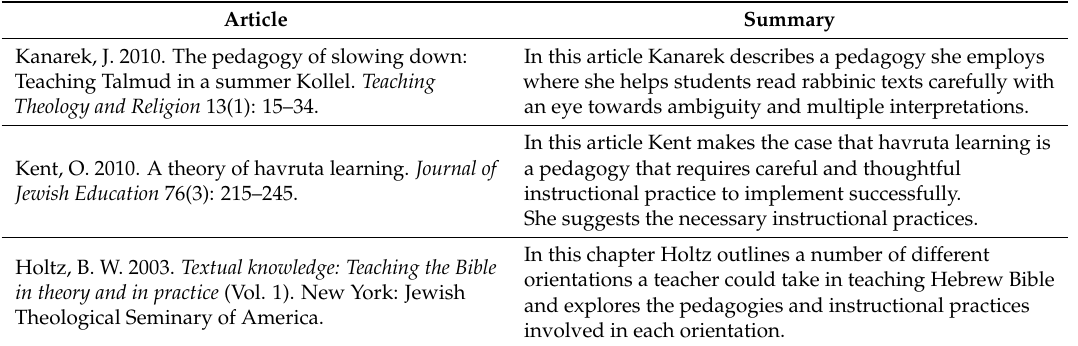
Table A1. Readings from the Small Study